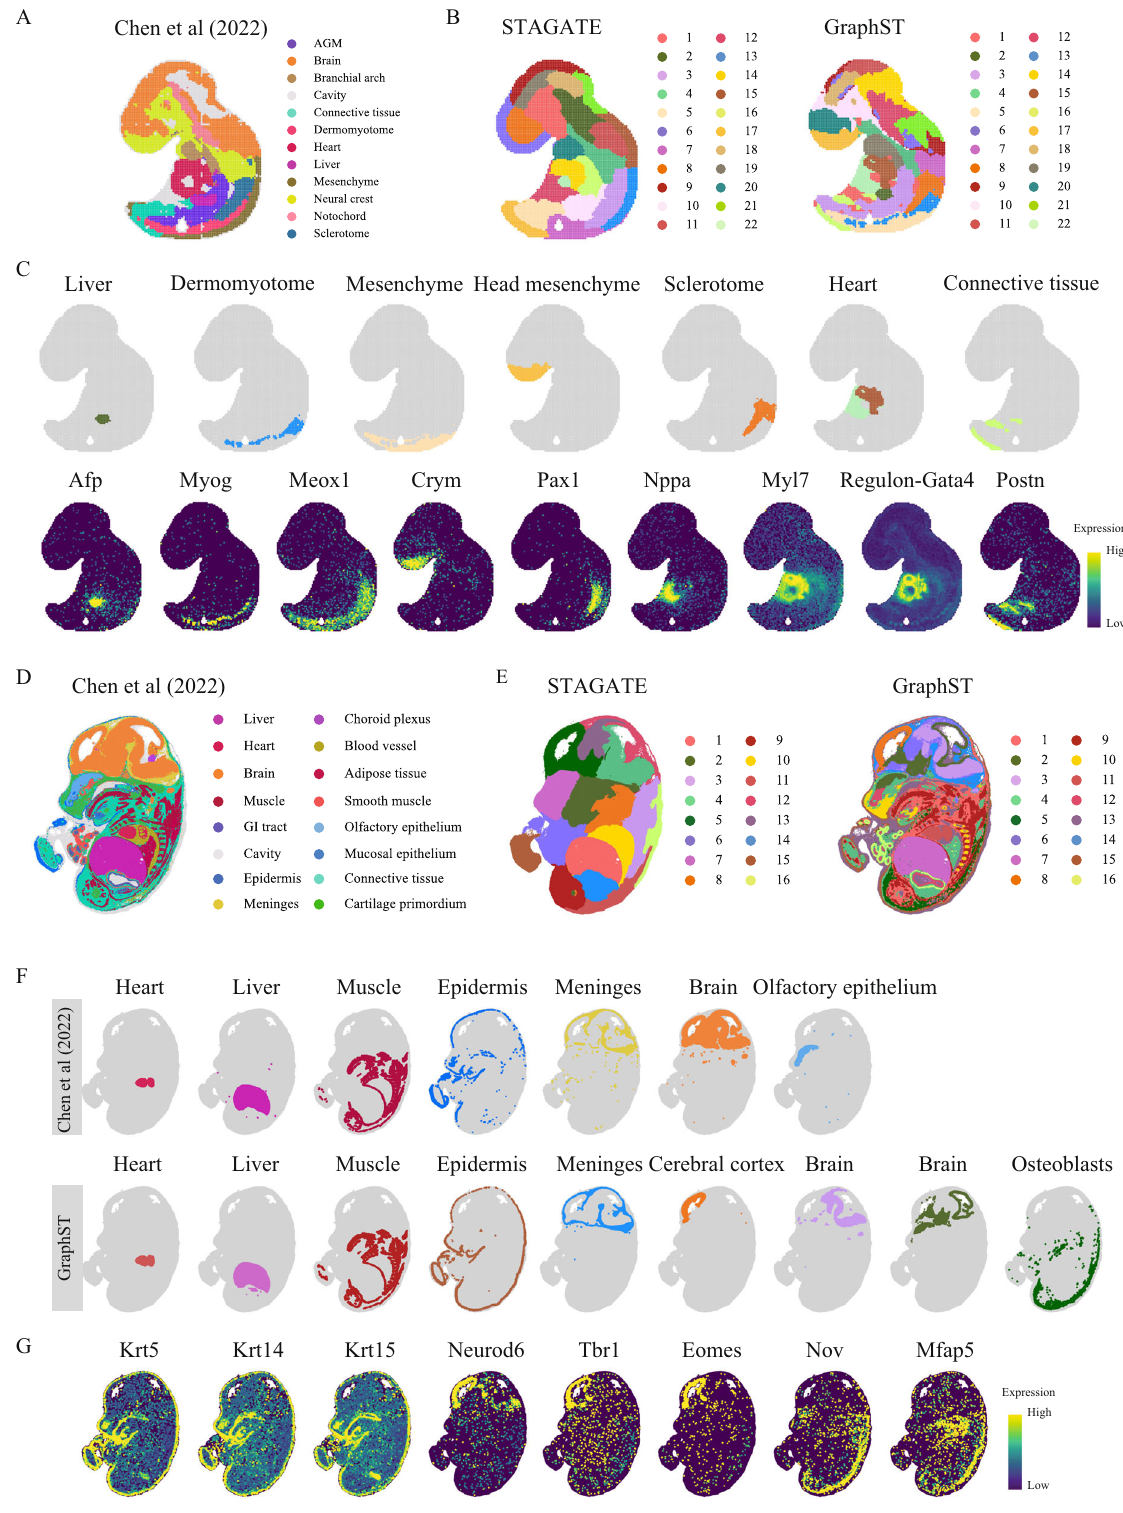
Fig. 3 | GraphST enables accurate identi fi cation of different organs in the Stereo-seq mouse embryo. A Tissue domain annotations of the E9.5 mouse embryo data taken from the original Stereo-seq study wherein the clusters were fi rst identi fi ed using Leiden clustering from SCANPY and then annotated using differentially expressed genes. B Clustering results of STAGATE and GraphST on the E9.5 mouse embryo data. C Visualization of selected spatial domains identi fi ed